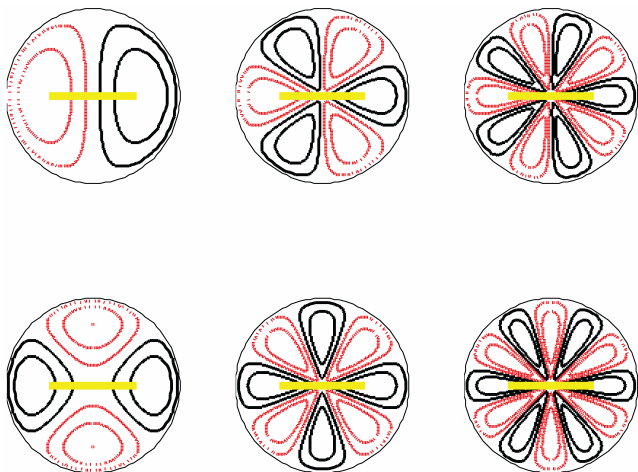
Figure C1. Schematic isolines for Fourier terms a s (ϕ) cos (sλ) for various zonal wave numbers s , shown in a polar projection. Positive- valued isolines are solid black, while negative-valued isolines are red dashed. The thick yellow line segments depict a part of a meridian. For odd wave numbers (upper panels), the yellow lines connect solid black contours to red dashed isolines – the function changes sign along the meridian.